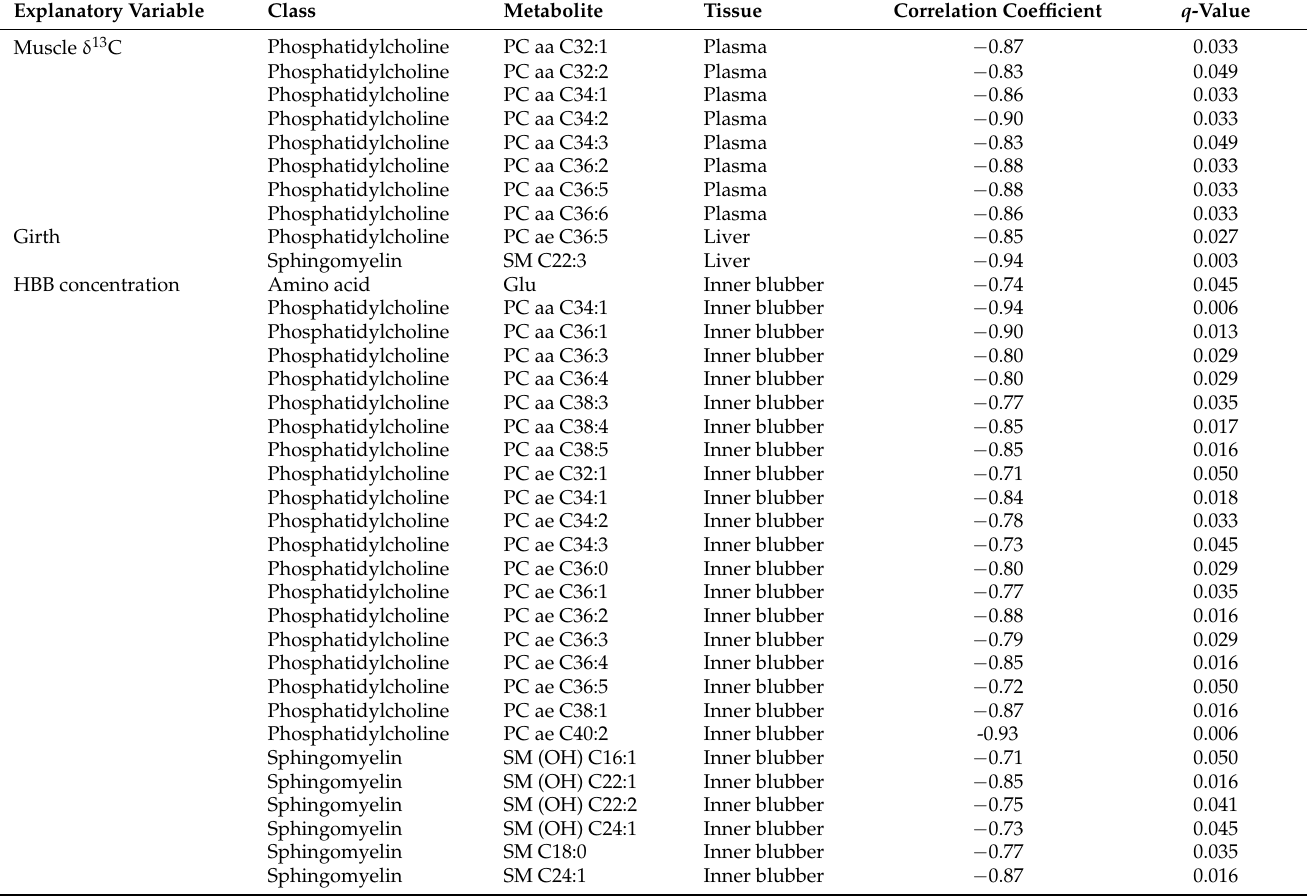
Table 3. Correlations between explanatory variables and percent contribution of metabolites quan- tified in plasma, liver, inner blubber or outer blubber of ringed seals from Lake Melville. Only the correlations that were significant after a FDR adjustment are presented in this table. The full name of each metabolite can be found in Table S5.